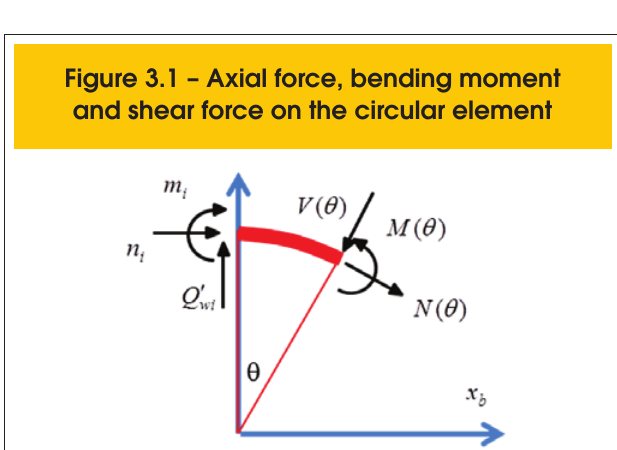
Figure 3.1 – Axial force, bending moment and shear force on the circular